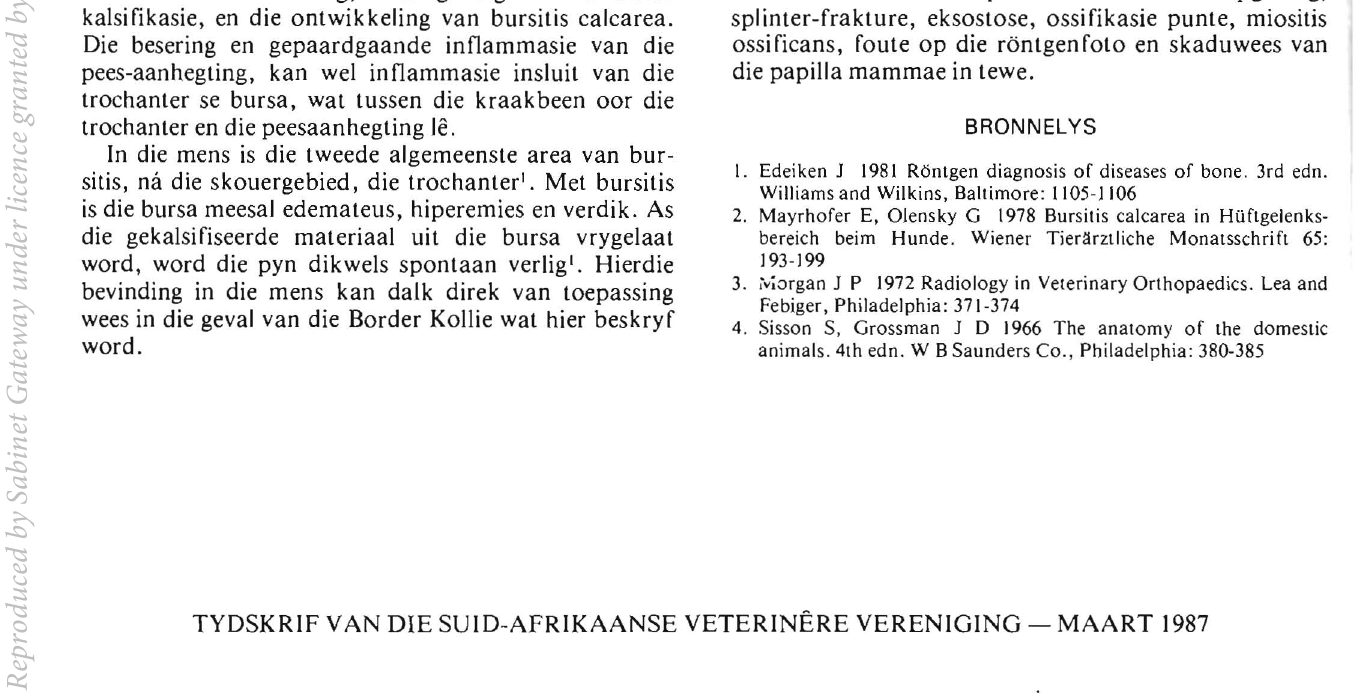
Dit mag amorf en multi-sentries wees, of dit kan duidelik as 'n meer omskrewe, uitstaande gekalsifi seerde digtheid waargeneem word. Laasgenoemde vorm neig om OOreen te stem met die radiologiese bevindings in gevalle van bursitis calcarea. Dit kan daarop dui dat die toestand tog moontlik deur trauma veroorsaak word, kliniese tekens tot gevolg mag he en as 'n uitstaande kalsifiseerde Iiggaampie(s) in die aangetasde weefsels waargeneem kan word. Die M. gluteus medius se